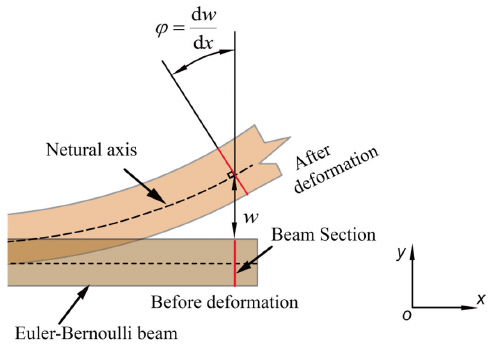
Figure 4. Deformation characteristics of a Euler–Bernoulli